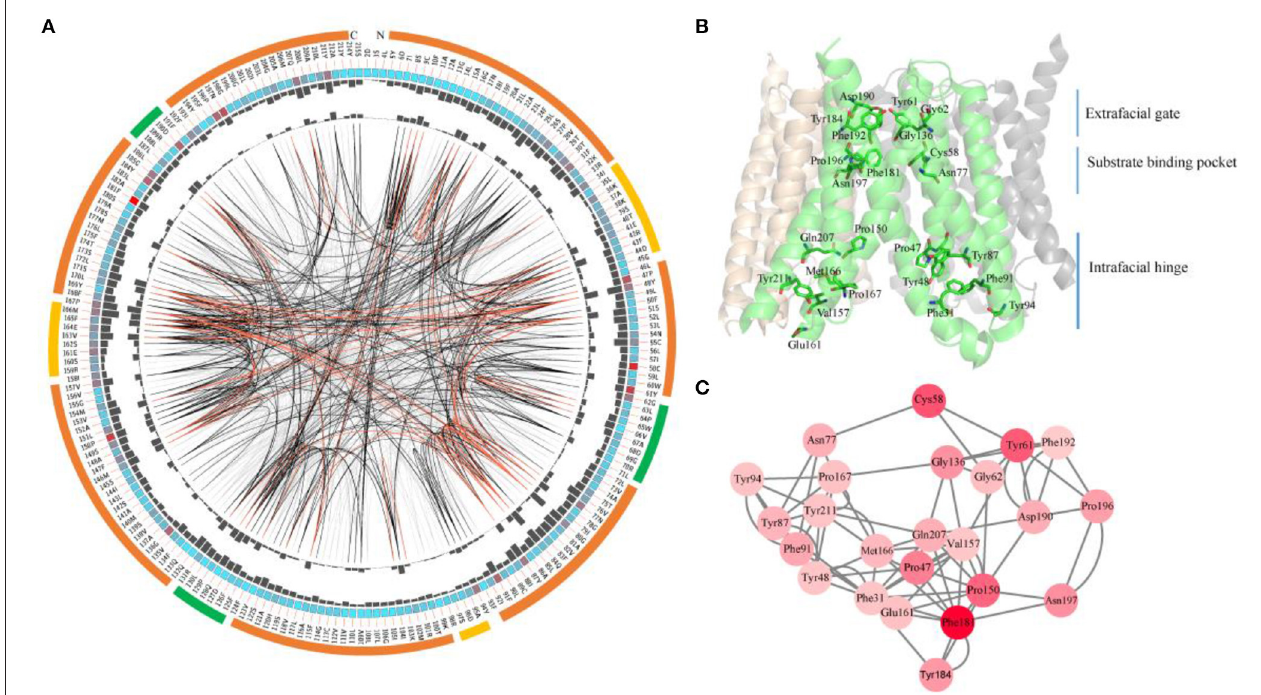
FIGURE 8 | Conserved and coevolved residues in SWEETs represented using OsSWEET2b as a reference sequence. (A) Network analysis of conserved and coevolving residues. The circular network shows the connectivity of coevolving residues. The outermost circle represents the TMHs (orange), the intrafacial region (yellow), and the extrafacial region (green). The labels in the second circle indicate the alignment positions and amino acids of OsSWEET. The colored square boxes in the second circle indicate MSA position conservation (highly conserved positions are shown in red and less conserved positions in blue). The third and fourth circles show the proximity mutual information (MI) and cumulative MI (cMI) values as histograms facing inward and outward, respectively. In the center of the circle, the edges that connect pairs of positions represent significant MI values ( > 6.5), with red lines indicating the highest MI scores (top 5%), black lines indicating midrange scores (between 70 and 95%), and gray lines indicating the lowest scores (the remaining 70%) as defined by MISTIC. (B) Ribbon diagram of OsSWEET2b (PDB ID: 5ctg) showing the 24 most coevolved and conserved residues. (C) The network cMI with high conservation value. Nodes represent the 24 most conserved residues (labeled with position and code) and nodes are colored to indicate conservation, from red (higher) to pink (lower). The length of each edge is inversely proportional to its MI value (the closest nodes have the highest MI values).